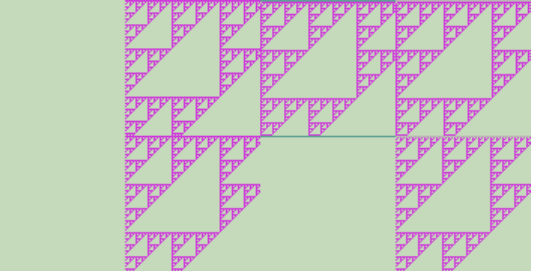
Figure 8. Standard sets of 90 × 90 image patterns associated to the complete graph K 4 ( top ) and the cycle C 4 ( bottom